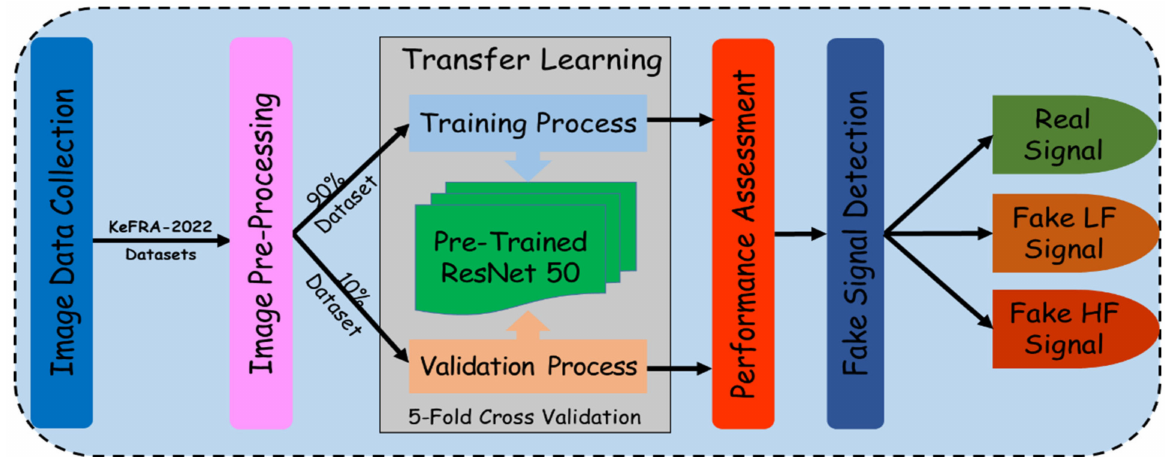
Figure 2. The overall architecture for the proposed detection